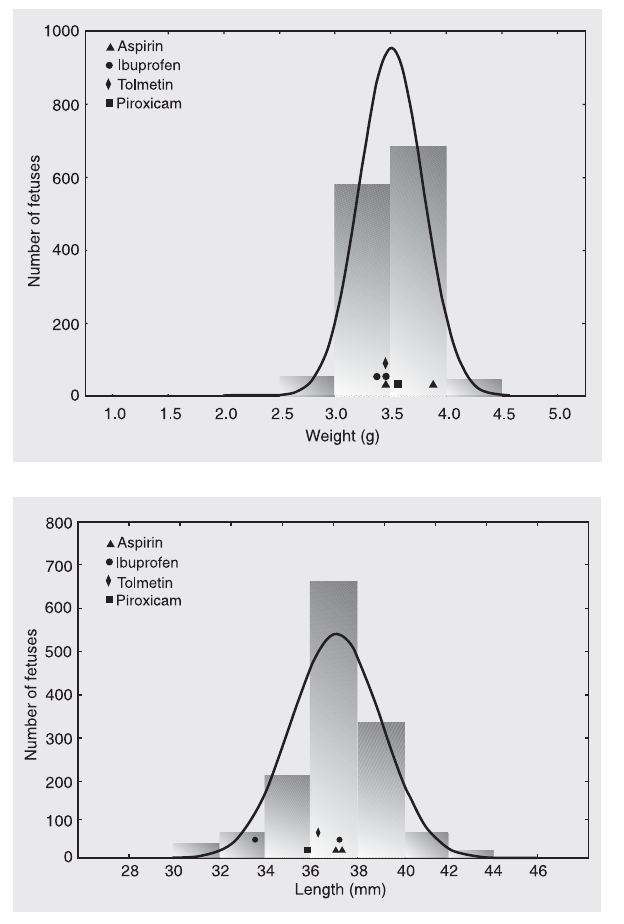
Figure 2. Crown-rump length of 21-day- old rat fetuses prenatally exposed to cyclooxygenase inhibitors. Each sym- bol indicates a single fetus with a ven-